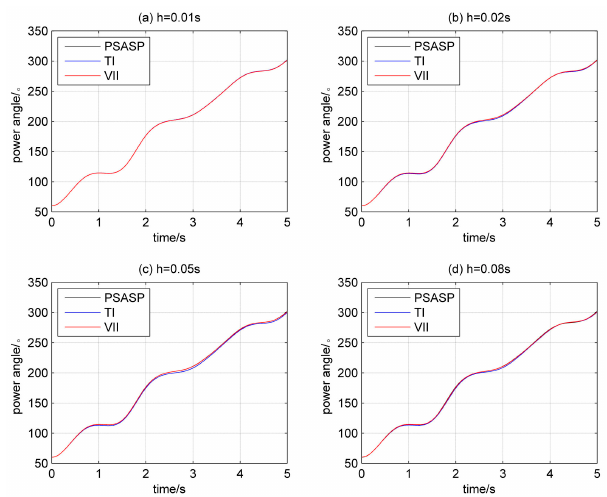
Figure 6. Power angle using different step sizes in case B.